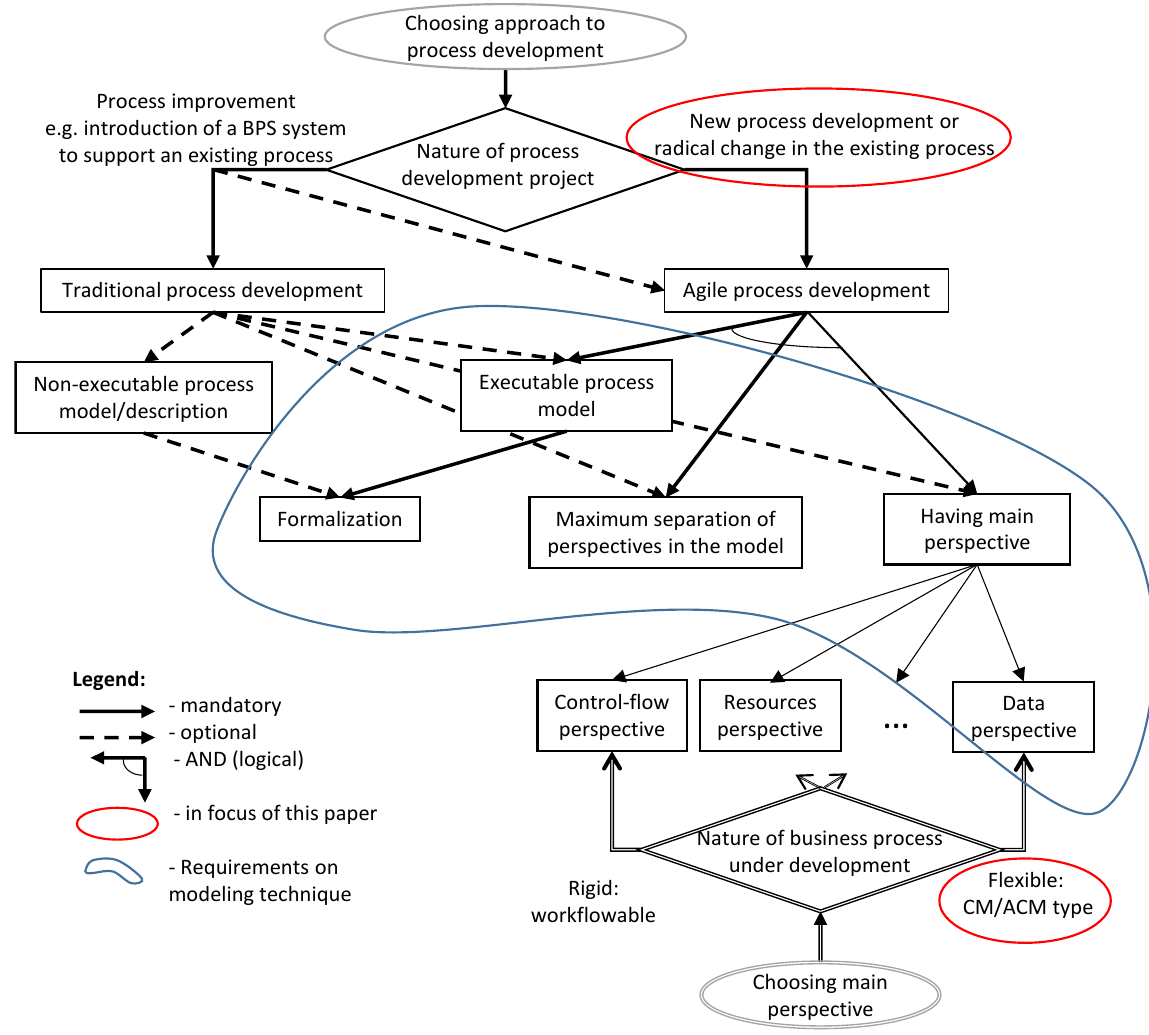
Figure 2. A rational behind the modeling technique suggested in this